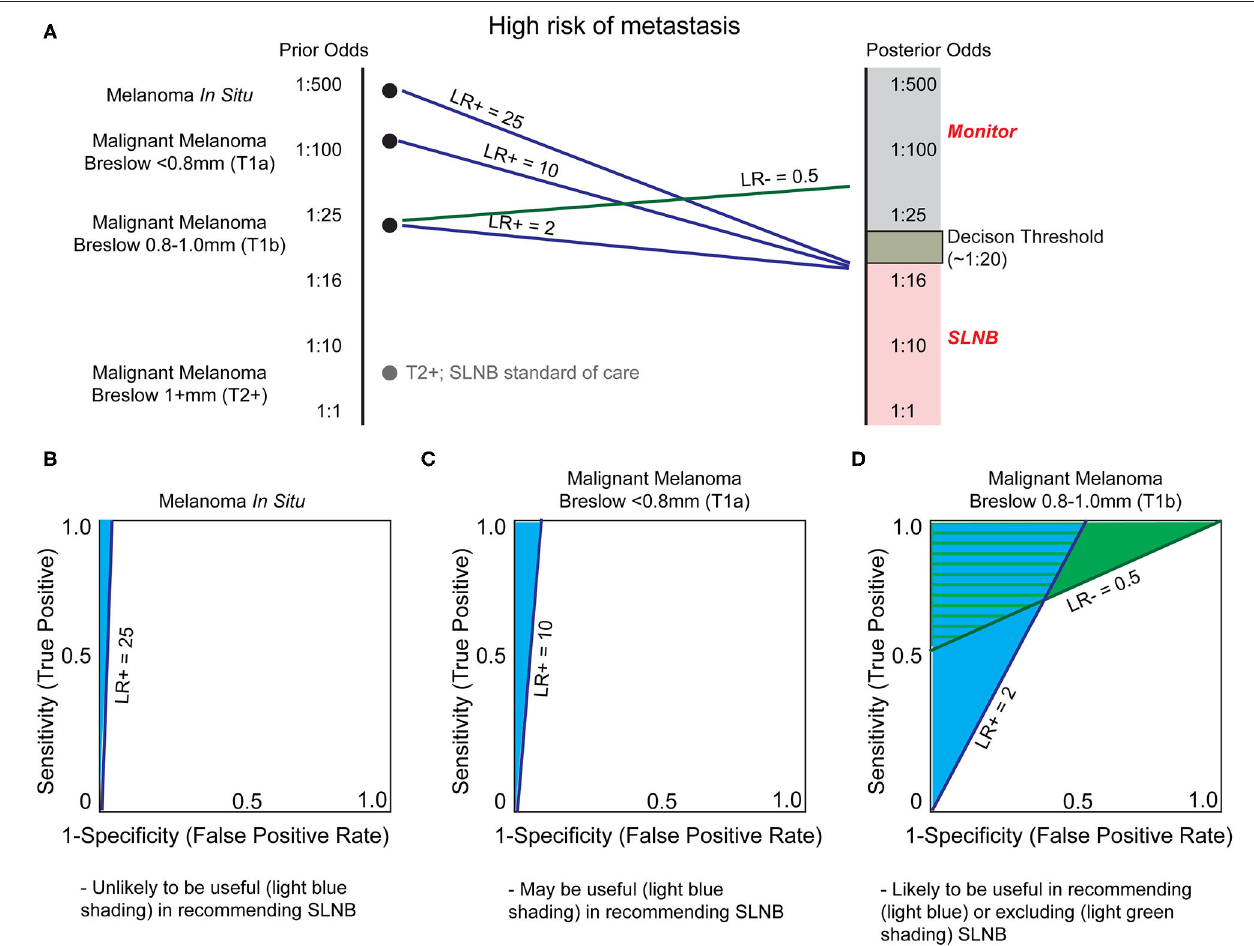
FIGURE 5 | Utility of biomarkers to augment Breslow depth in determining which patients are offered sentinel lymph node biopsy (SLNB). (A) As depth of melanoma increases, from in situ to greater than one millimeter, the probability of sentinel lymph node positivity, and thereby stage and treatment selection, increases. Sentinel lymph node biopsy (SLNB) is positive in ∼ 5% of patients with T1b melanoma, resulting in a decision threshold posterior odds of ∼ 1:20 for many surgical oncologists to offer SLNB and reflecting NCCN guideline recommendations (90). As SLNB is not routinely offered for melanoma in situ or T1a melanomas, the incidence of SLNB positivity is unknown. We therefore estimate that these are substantially and progressively less positive as tumor thickness decreases. SLNB is standard of care for T2 + melanomas (gray dot) and thus no biomarker is likely to alter this recommendation without exceptionally low LR- test characteristics. (B) Currently patients with melanoma in situ are not generally offered SLNB since the likelihood of positivity (prior odds) is very low. A very high LR + , estimated at 25, would be necessary to recommend SLNB. (C) As the melanoma Breslow depth increases, the prior odds of sentinel lymph node metastasis increases (becomes closer to 1:1). Therefore, a lower LR + , such as LR + ≥ 10, would be necessary to prompt SLNB. (D) Biomarkers may have the greatest utility for T1b malignant melanomas. Current NCCN guidelines recommend thoughtful consideration of SLNB based on patient-specific factors, and any test that could offer relatively small changes in certainty could be of great clinical utility. Thus, a modest LR + of 2.0 or LR– of 0.5 may be sufficient for a clinically-actionable